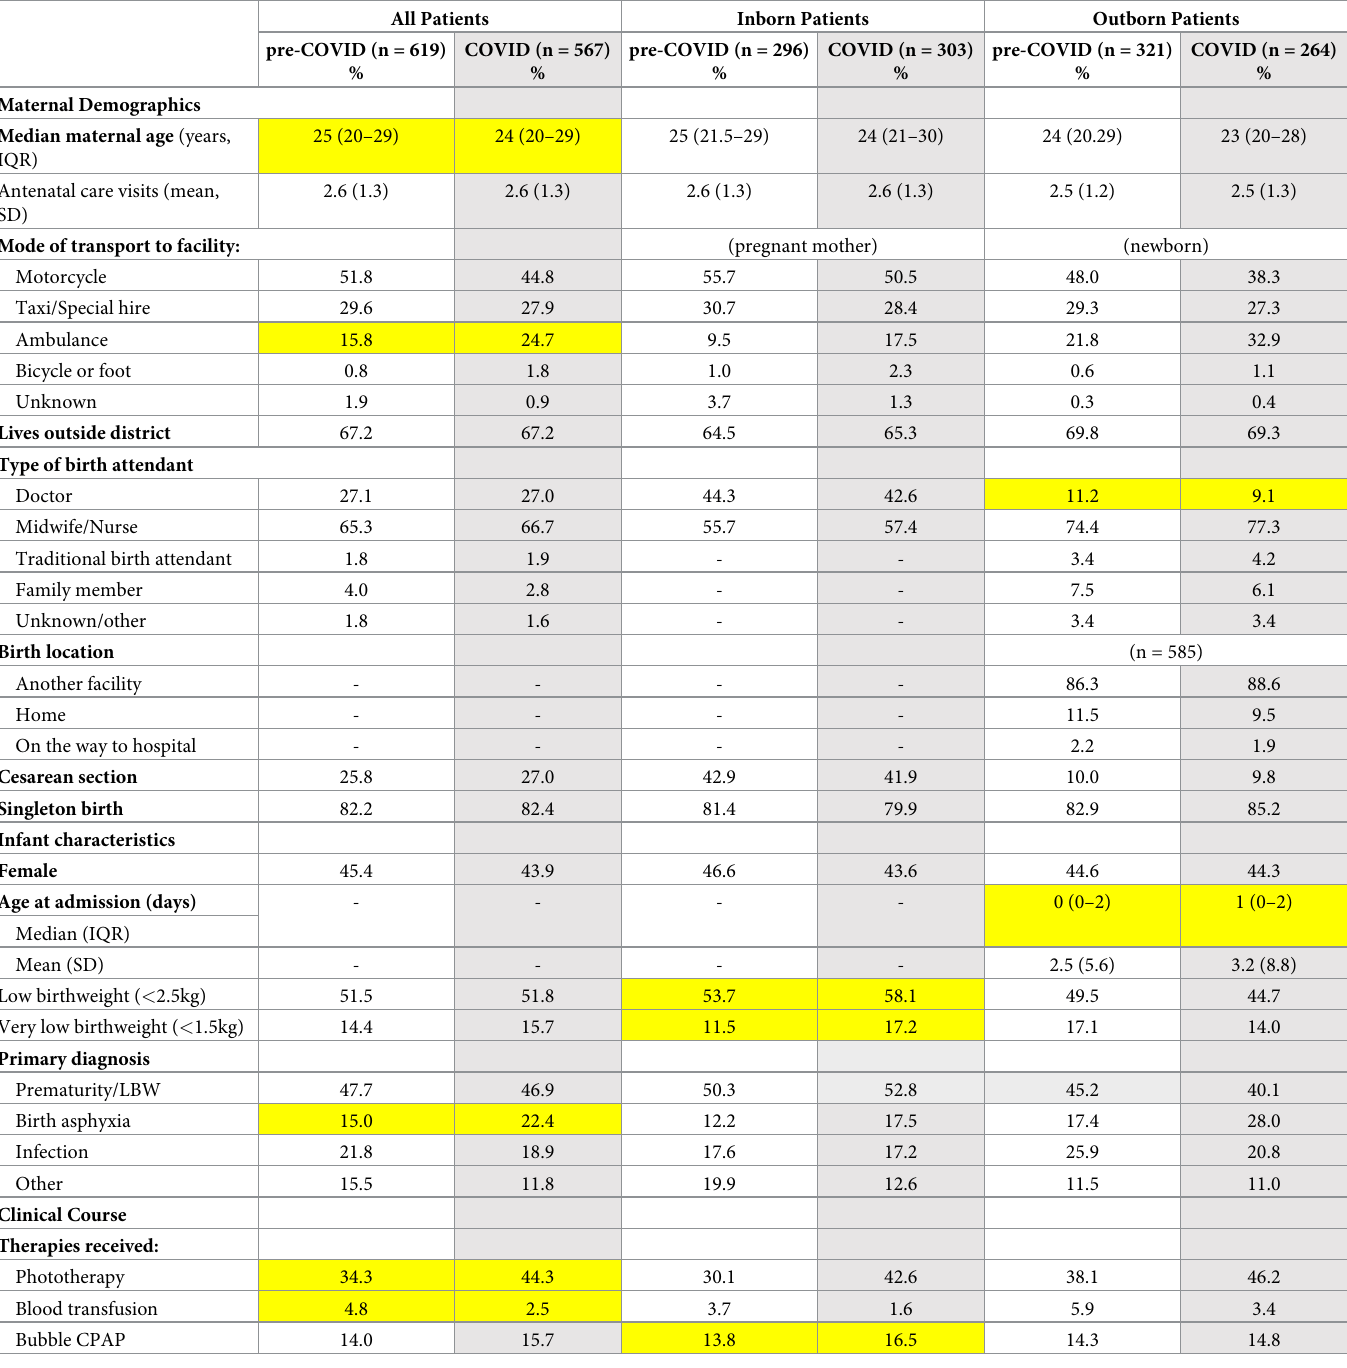
Table 2. Maternal and neonatal demographics and clinical characteristics during pre-COVID (October 19 –March 20) and early COVID periods (April–September 2020) by birth location. All